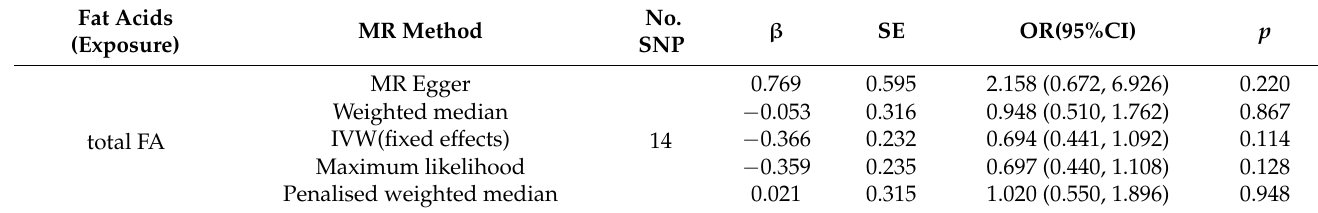
Table 2. MR analysis results of diverse fatty acids (FAs) and Crohn’s disease (CD). Fat